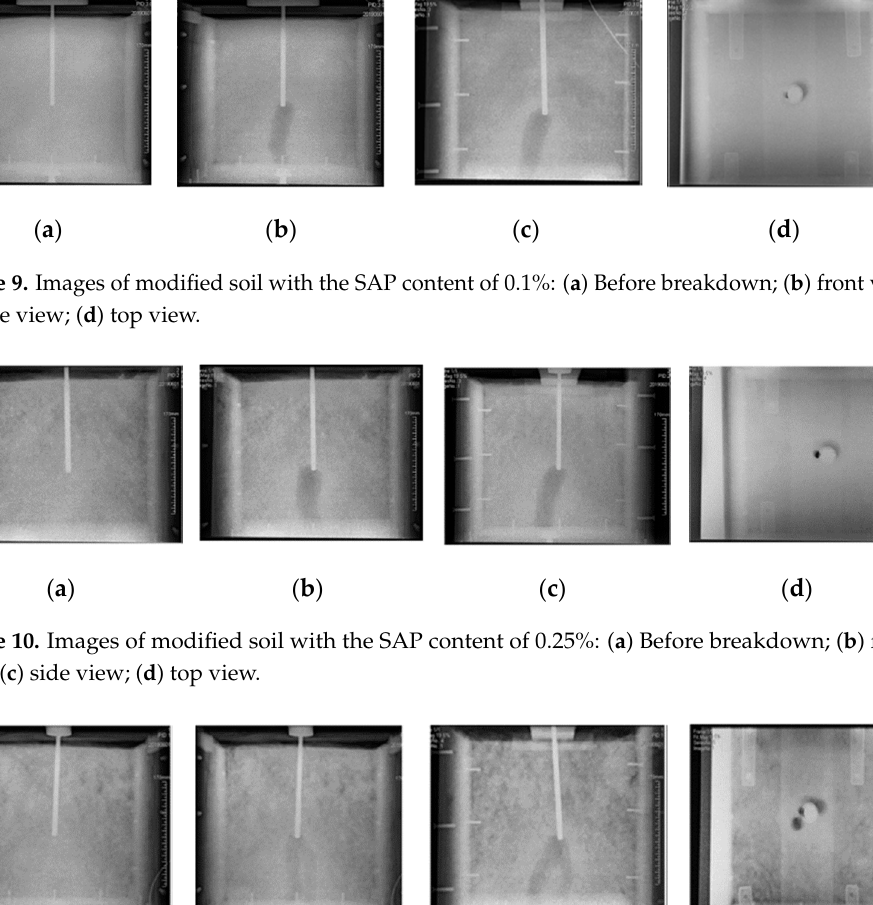
Figure 12. Current and voltage waveform of soil without SAP when injected into the impulse cur- rent.